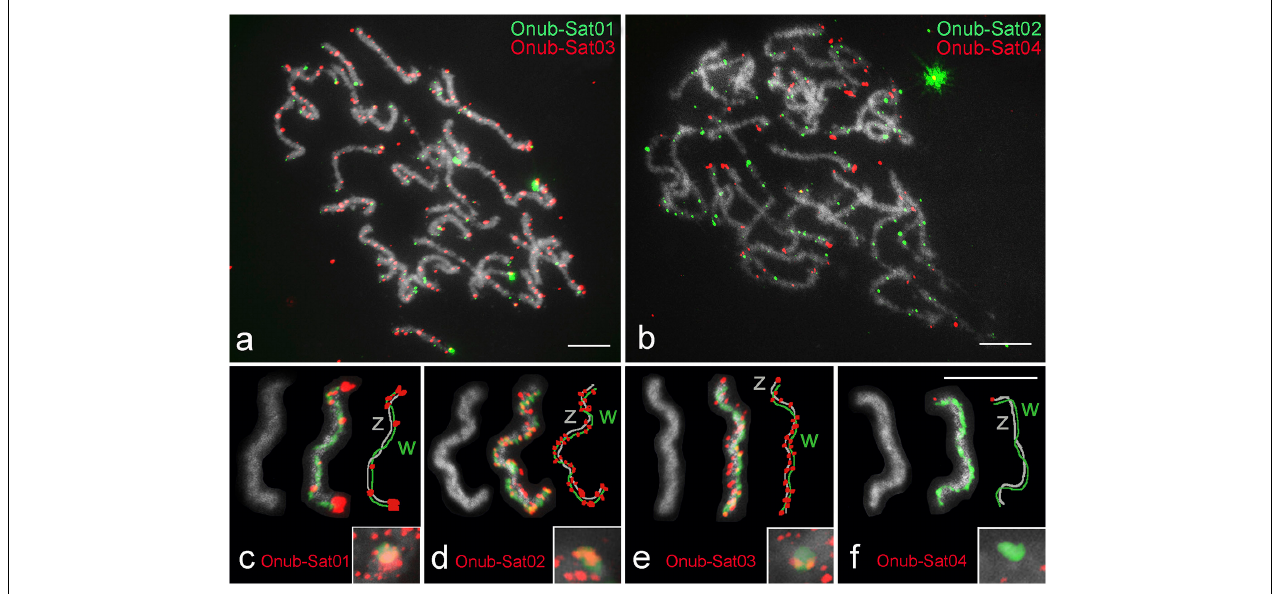
FIGURE 7 | Localization of four satDNAs identified from the genome of Ostrinia nubilalis . (a,b) Male pachytene. In panels (c–f) , selected WZ bivalents from pachytene oocytes stained with DAPI (gray), probed for individual satDNAs (red) and with the W chromosome identified by W-painting probe (green) are shown. Schematic representations of each WZ bivalent showing the W (green) and Z (gray) chromosomes and the satDNA distribution (red) are also given in panels (c–f) . The insets in panels (c–f) show hybridization signals of the probes on W chromatin from interphase nuclei. Probes are indicated in each image. Bar = 10 µ